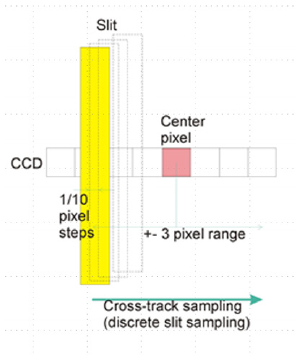
Figure 5. UVVISII detector